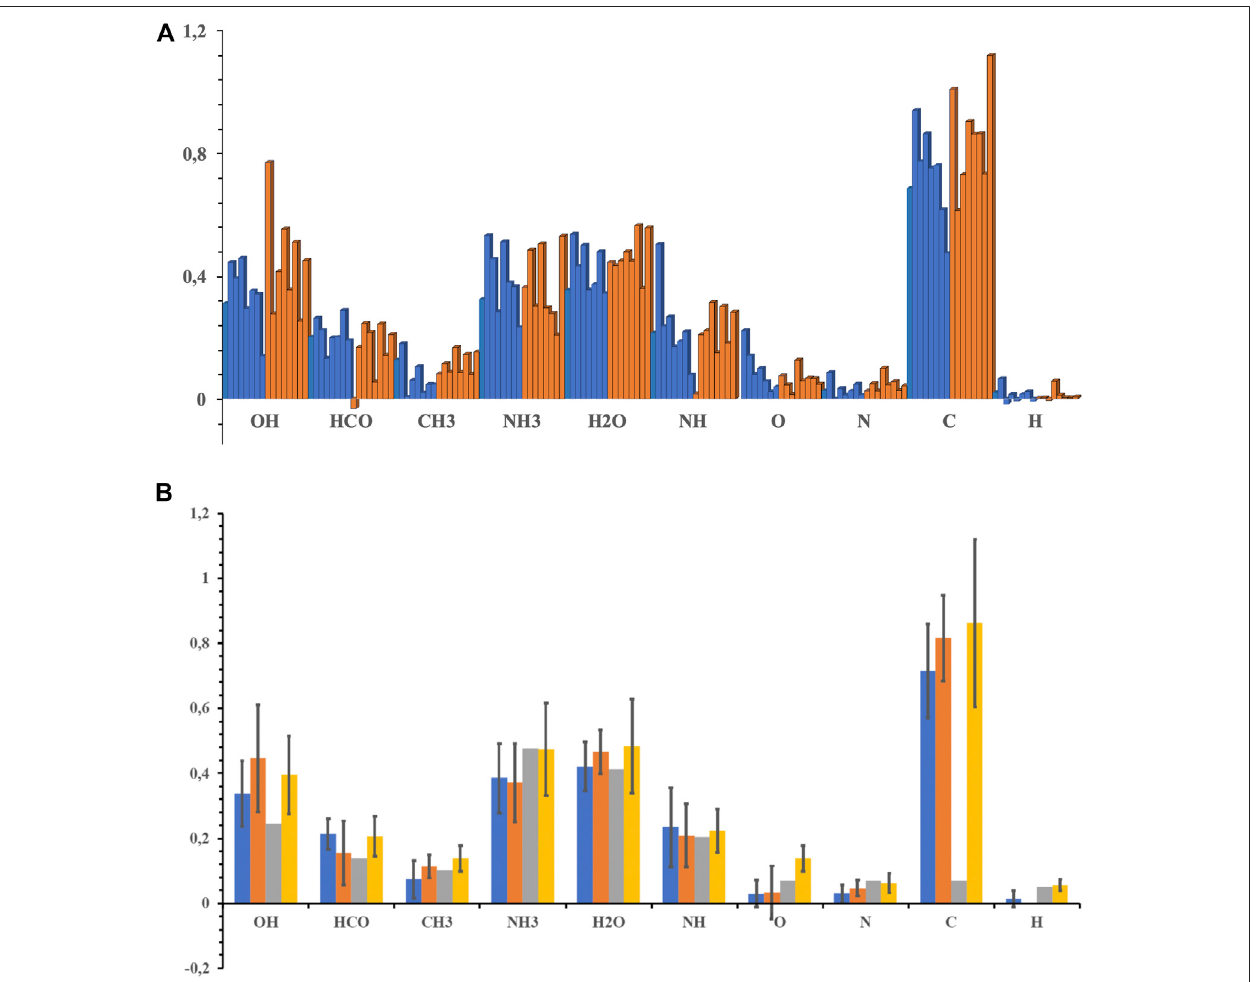
FIGURE 11 | (A) Summary of CBS BE (in eV) distributions for crystalline (blue) and amorphous (orange) ices (B) Comparison of calculated average BE ’ s (with standard deviation) between crystalline (blue) and amorphous (orange) ice. Values, when available, taken from UMIST (McElroy et al., 2013) and KIDA (Wakelam et al., 2012) databases are also represented in grey and yellow,